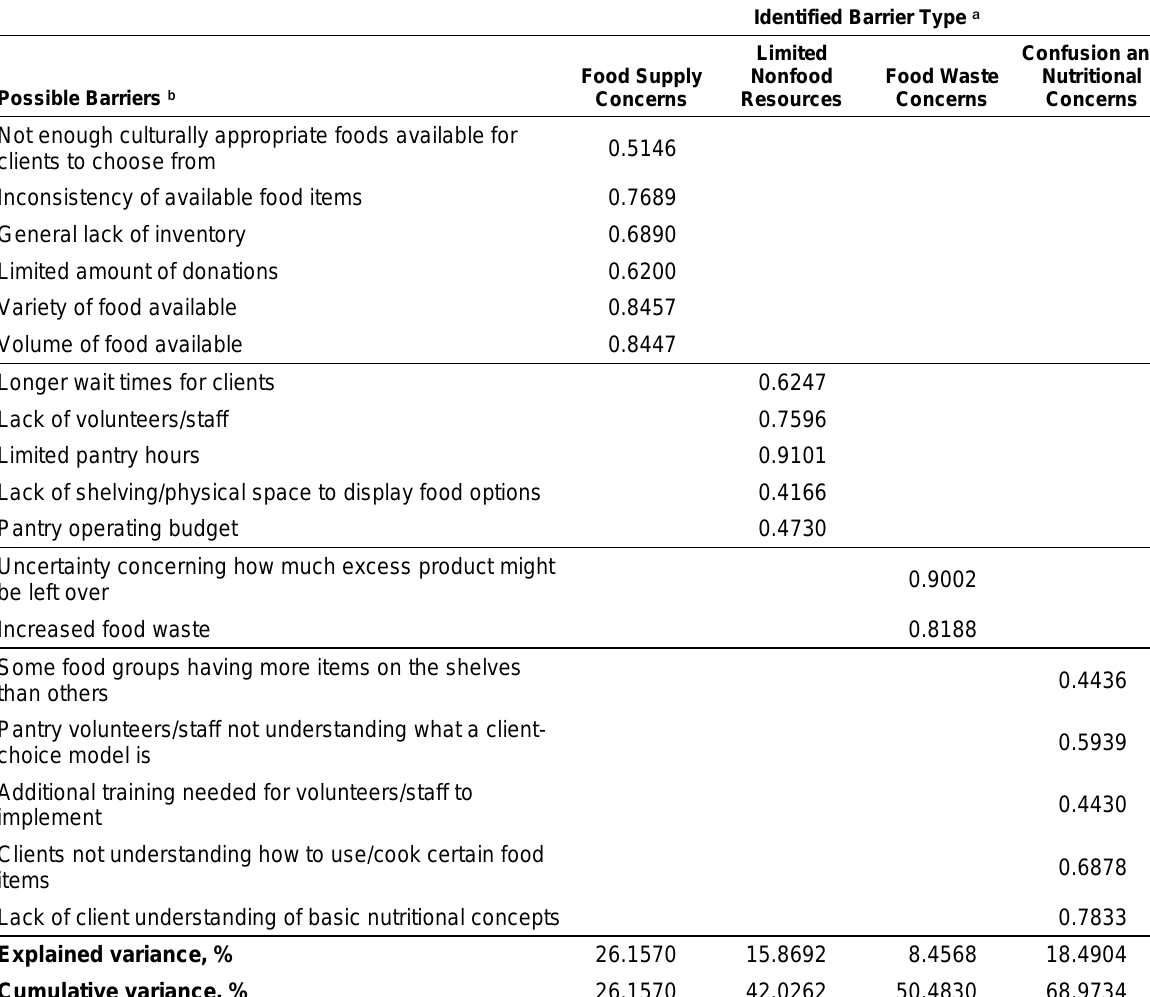
Table 1. Rotated Factor Loadings for Possible Barriers to Implementing a Client-Choice Model, by Identified Barrier Type ( n